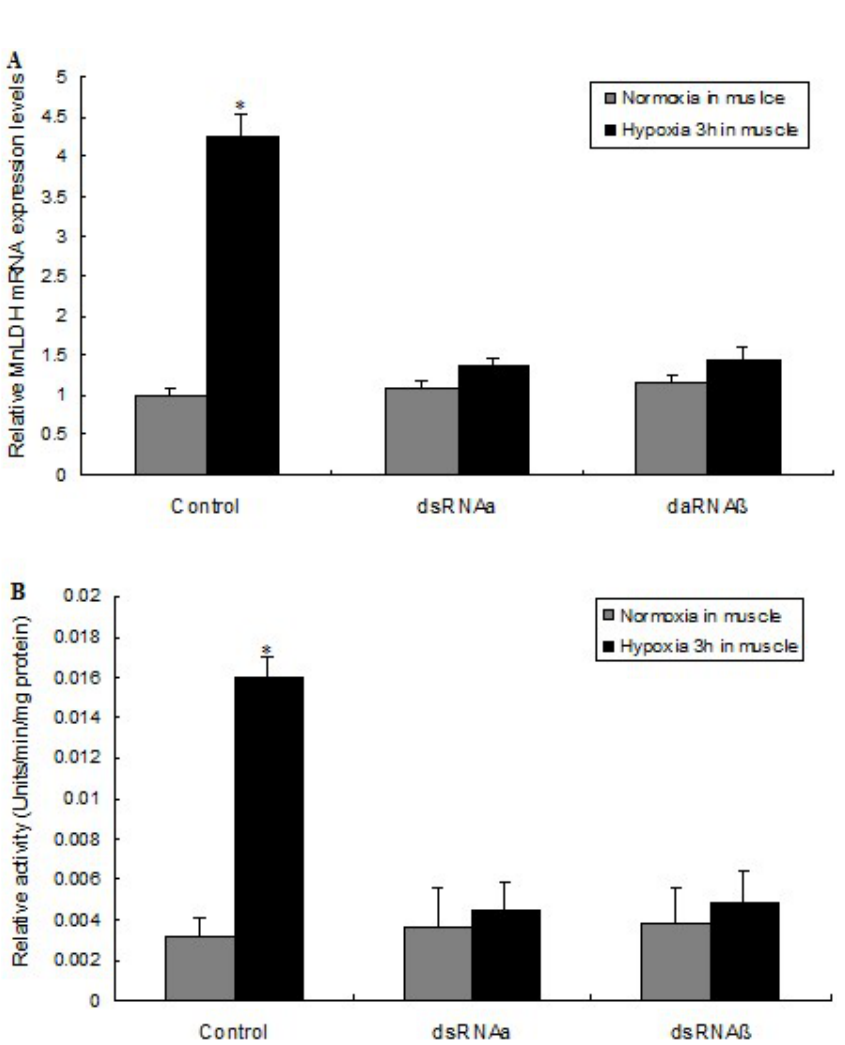
Figure 7. LDH mRNA level ( A ) and enzyme activity ( B ) in muscle from M. nipponense exposed to hypoxia and HIF-1 silencing. The prawns were exposed to hypoxia (2.0 mg/L O 2 for 1 h) and injected with saline solution (control), dsRNAα or dsRNAβ. * indicates significant differences ( p < 0.05) between the control and dsRNAα groups, or between the control and dsRNAβ, respectively. Vertical bars represent mean ± SEM values for triplicate samples.